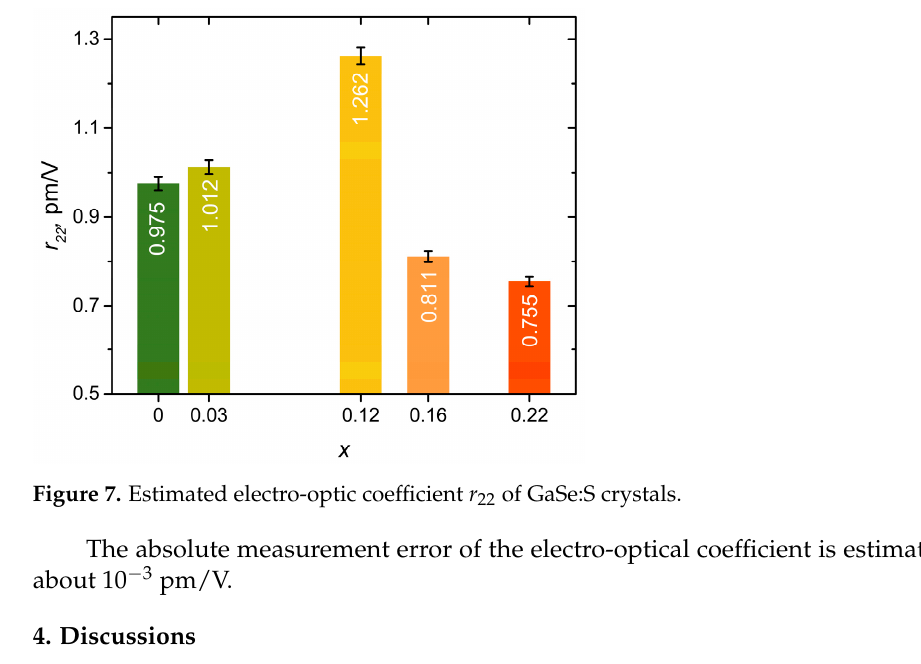
Figure 9. Ordinary refractive index of the GaSe:S crystals at λ = 1547 nm. Data, measured in this work, are presented in bars and compared with the results published in other works: Allakhverdiev (1982) [34], Allakhverdiev (2005) [39], Takaoka (1999) [40], Vodopyanov (1995) [41], Abdullaev (1975) [42], Kato (2011) [56], Abdullaev (1972) [64], McMath (1976) [65]. Some data for undoped GaSe is shifted horizontally for better readability. In the terahertz range, the value of the ordinary refractive index is in good agreement between most studies. For example, the values for undoped crystals lie in the range from 3.24 to 3.264, which approximately corresponds to an interval of 0.78%. An exception is the work of Yu et al. (2005) [63] in which the refractive index differs significantly from other studies (Figure 8). The authors also report a rather high absorption coefficient for the crystal, which is inconsistent with data from other works in which high ‐ quality crys ‐ tals were studied. In our case, the crystals also show an extremely low level of absorption for THz waves. The samples in [63] have a high DC conductivity, possibly due to the de ‐ fects in the crystals. Such conductivity makes a significant contribution to the dielectric susceptibility of the material and, as a consequence, leads to an increase in the refractive index and absorption coefficient at THz frequencies. Figure 9 shows ordinary refractive index of the GaSe:S crystals at λ = 1547 nm. Since no study has performed direct measurements at this wavelength, the value of the refrac ‐ tive index has been estimated using the suggested in the works Sellmeier equations. It can be seen that the old studies carried out by Abdullaev et al. (1975) [42] and Allakhverdiev et al. (1982) [34] reveal a significant deviation from our results, which may be explained